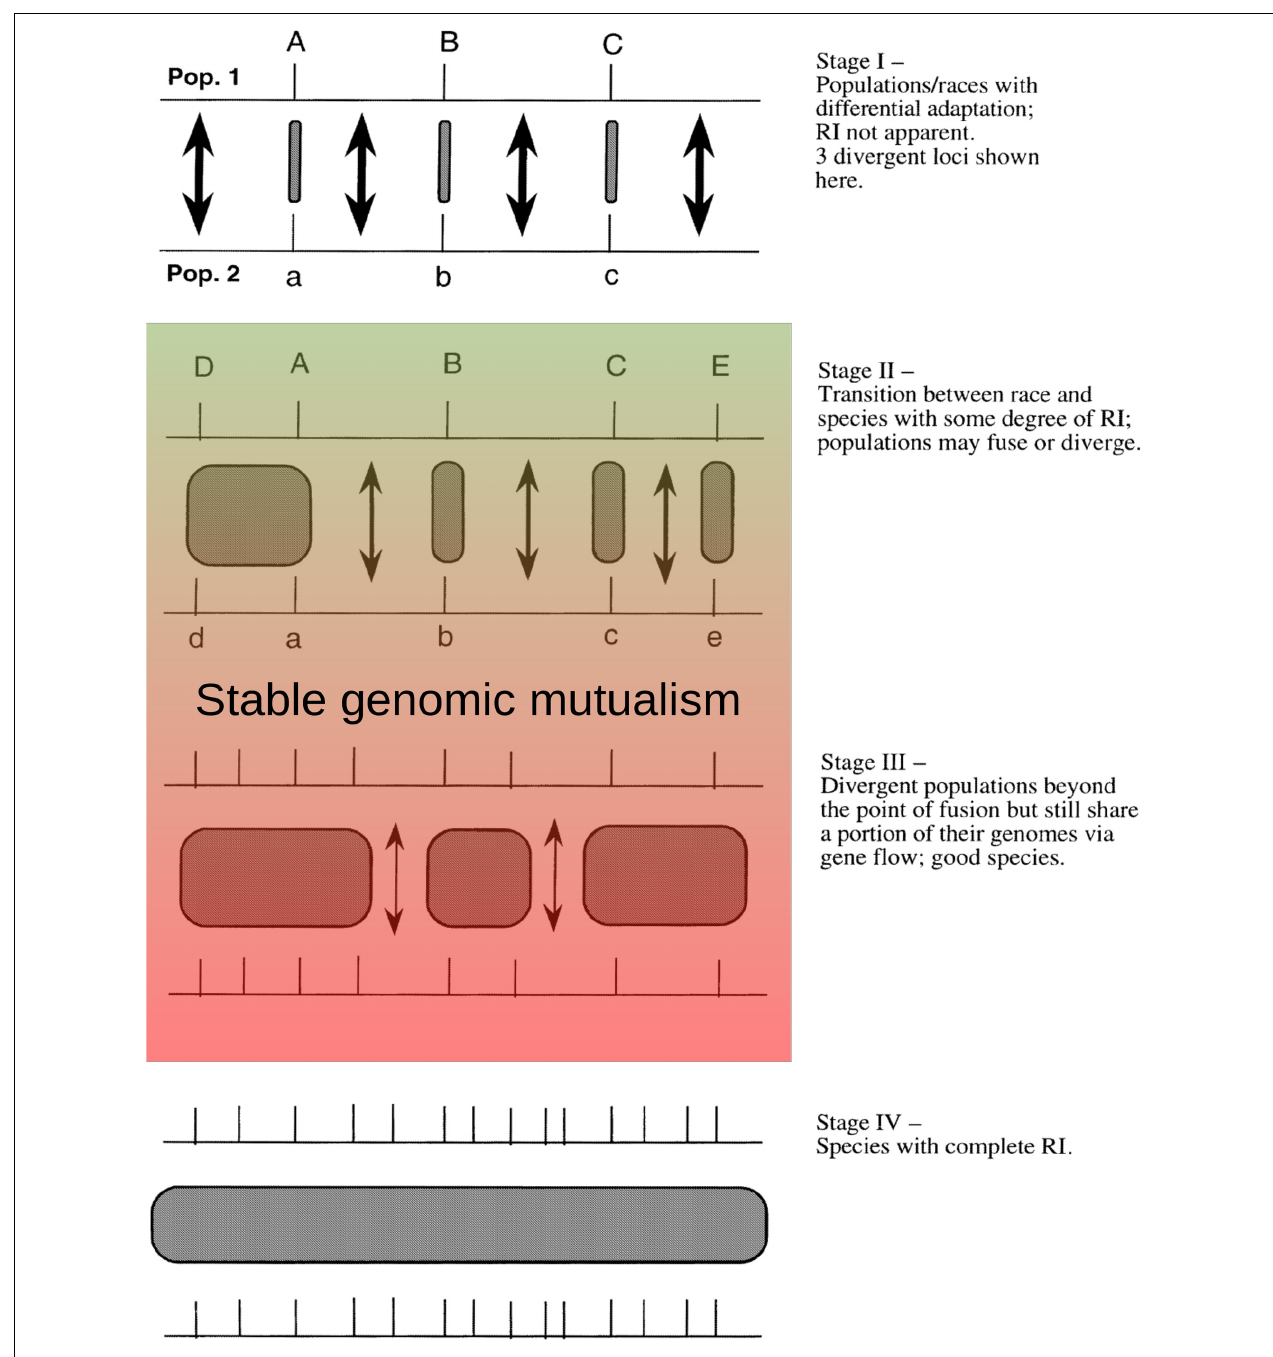
FIGURE 5 | Intermediate and diminished gene flow proposed among stable genomic mutualists as adapted from Wu’s